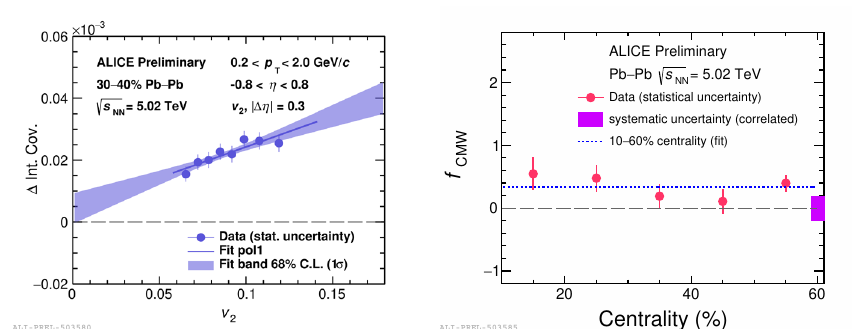
Figure 2. Left: Linear dependence of ∆ Int . Cov . on v 2 of shape-selected events in 30–40% centrality class in Pb–Pb collisions at √ s NN = 5 . 02 TeV. Right: Extracted CMW fraction as a function of central-